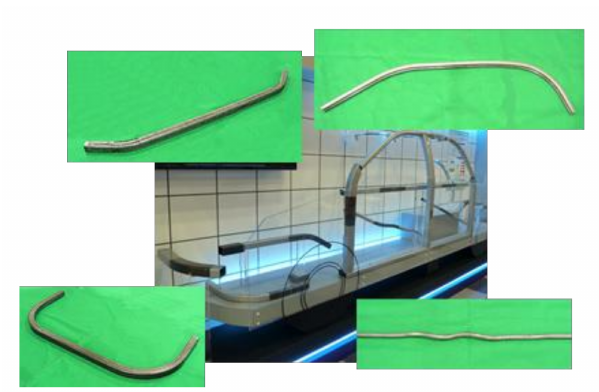
Figure 4. Examples of automotive products by